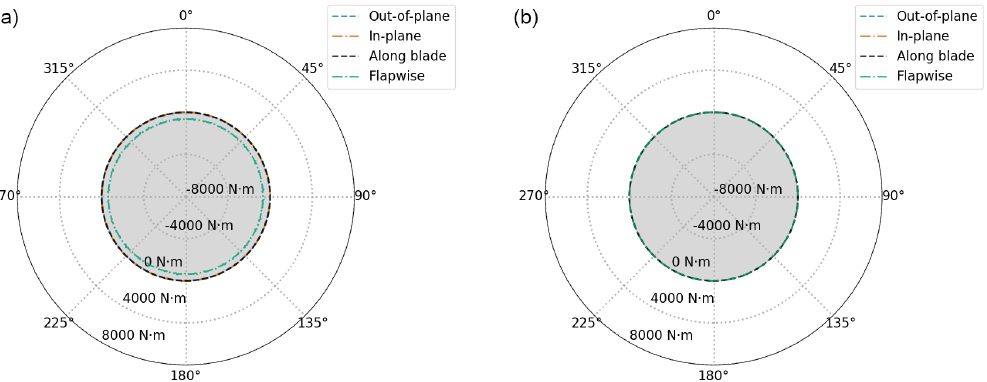
Figure 5. Load contributions (out-of-plane in dashed blue, in-plane in dashed–dotted orange, along blade in dashed black and flapwise in dashed–dotted green) to the yaw moment at tower top combined for the three blades with respect to azimuth (20ms − 1 uniform wind speed) with (a) and without (b)